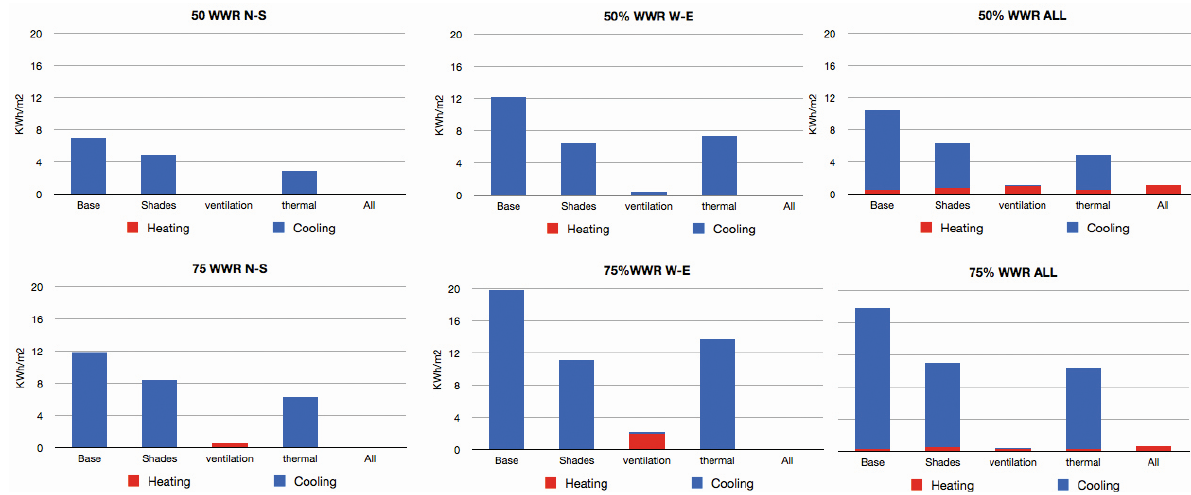
Figure 18. Prediction of cooling and heating loads for all cases that have been simulated.